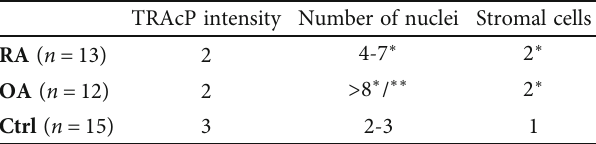
Table 3: Cell morphology in synovial fl uid assay. TRAcP intensity Number of nuclei Stromal cells